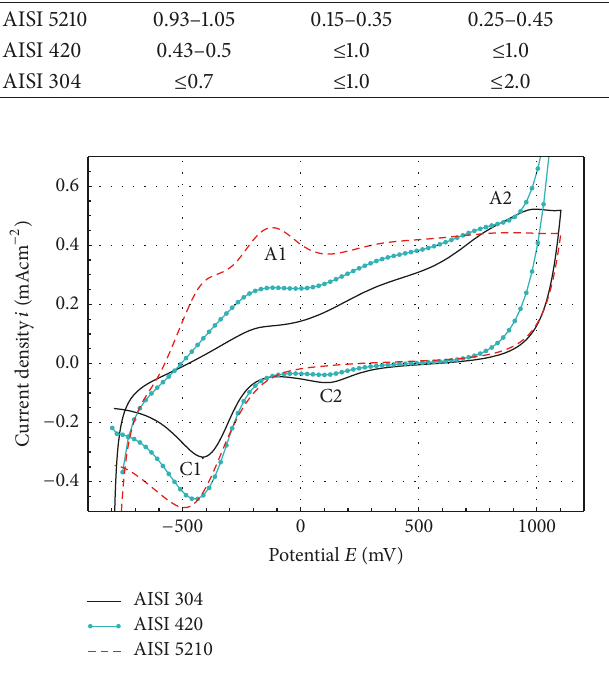
Figure 2: 10th cycle of cyclic voltammograms for AISI 5210, AISI 420, and AISI 304 recorded in phosphate buffer. The scans are recorded from − 800mV to 1100mV with a scan velocity of 100 mVs −1 . For each electrode the 10th cycle is displayed. All potentials are measured against the Ag/AgCl